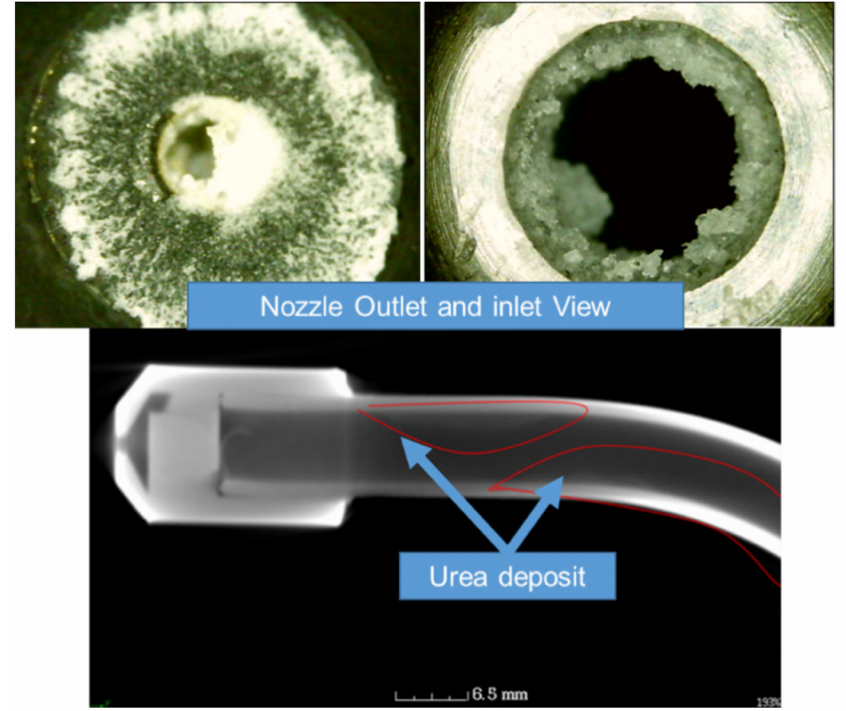
Figure 2. The solid deposit formation inside the original urea injector from the Hyundai D6CC diesel